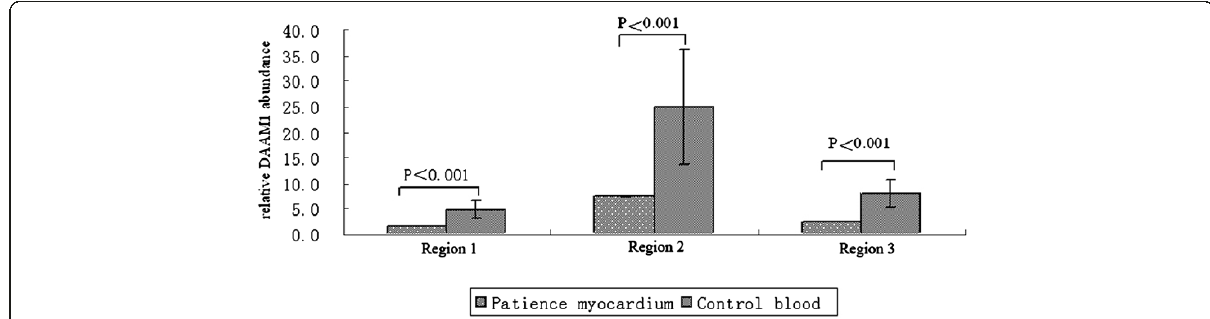
Figure 3 Quantification of DAAM1 abundance in the CHD fetal myocardium and the control blood. DAAM1 was significantly lower in the fetal myocardium than that in the control blood (P<0.01). Error bars were the standard deviation (n ≥